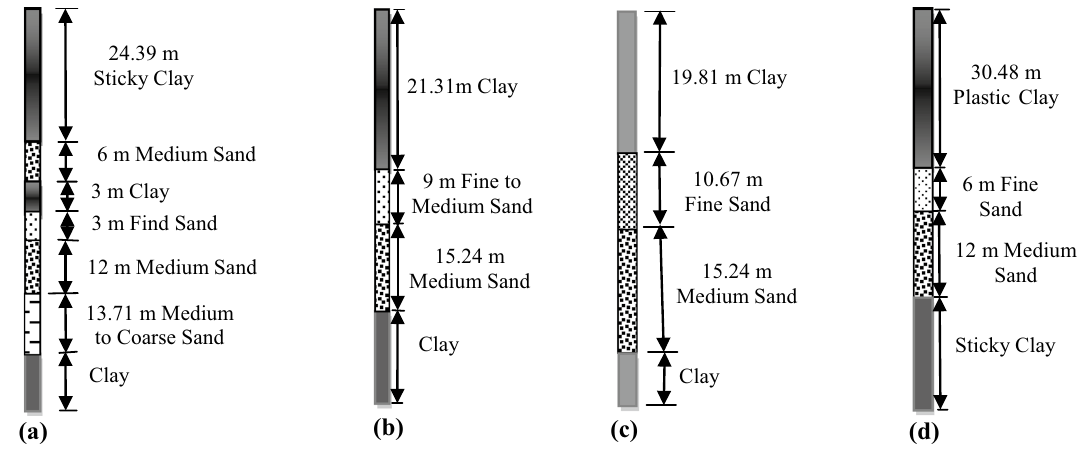
Fig. 11 Bore log lithology- a Mouza-Muradpur-2, J.L. No- 148, Plot No.-437 Upazila- Nachole, District- Chapai Nawabgonj; b Mouza- Nimdighi, J.L. No.- 151, Plot No.-768,Upazila- Niamatpur,